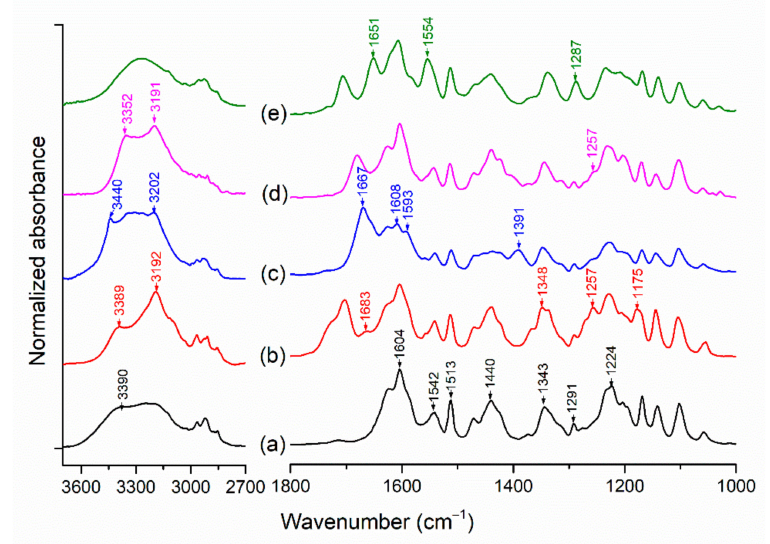
Figure 11. FTIR spectra of ( a ) xanthohumol, and the investigated cocrystals: ( b ) XN − GA, ( c ) XN − AC, ( d ) XN − NIC, and ( e ) XN −